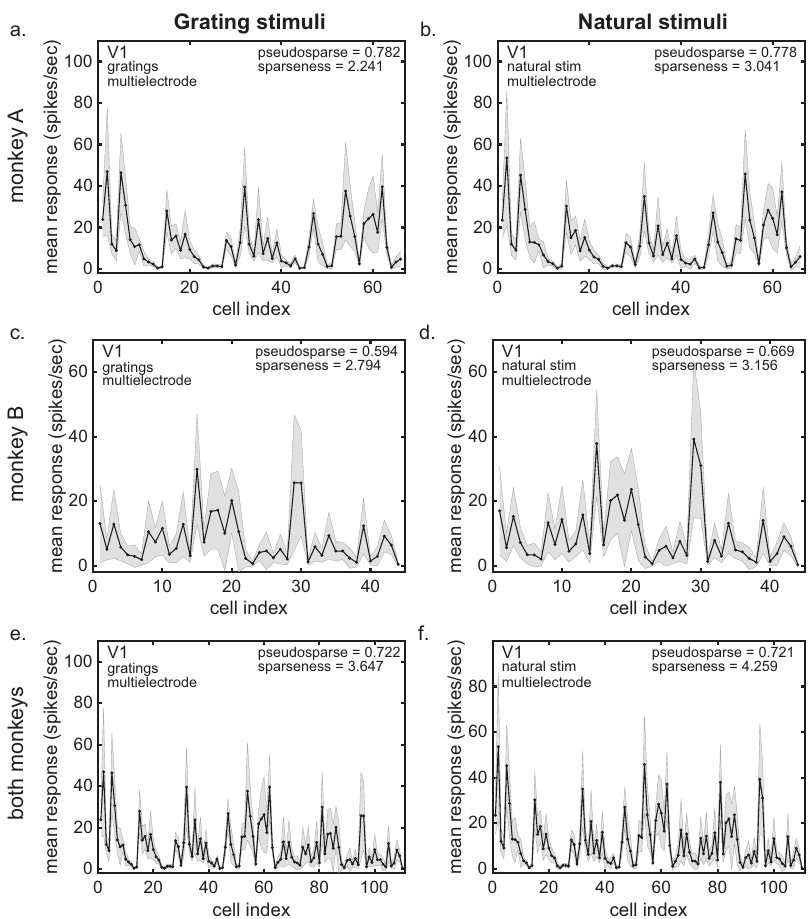
Fig. 2 Response spectra for V1, using multielectrodes with grating and natural stimuli. a Monkey A response spectrum using grating stimuli. N = 66 neurons with n = 416 stimuli per neuron. b Monkey A response spectrum using natural stimuli. N = 66 neurons with n = 540 stimuli per neuron. c Monkey B response spectrum using grating stimuli. N = 44 neurons with n = 416 stimuli per neuron. d Monkey B response spectrum using natural stimuli. N = 44 neurons with n = 540 stimuli per neuron. e Pooled data from both monkeys using grating stimuli. f Pooled data from both monkeys using natural stimuli. Neurons were the same for each monkey when using grating or natural stimuli (Data from Coen-Cagli et al. 29 ). Mean pseudosparseness and median sparseness values (median because sparseness values are strongly right skewed) are given here and in subsequent fi gures. Gray error bars represent standard